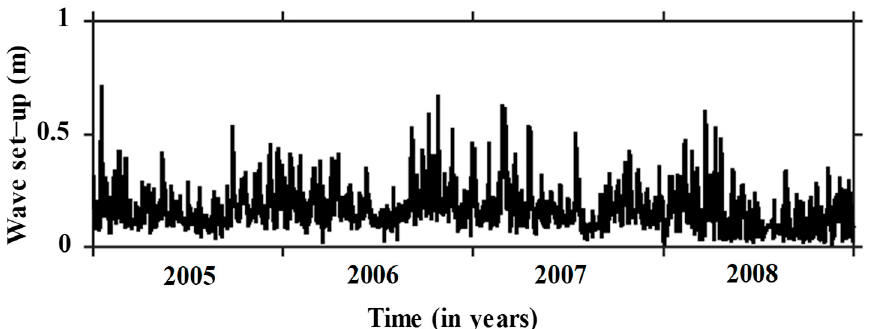
J. Mar. Sci. Eng. 2019 , 7 , 45 Figure 15. The variations in wave set-up during 2005–2008. Figure 15. The variations in wave set-up during 2005–2008. y = 1.0139x + 0.1712 R = 0.98